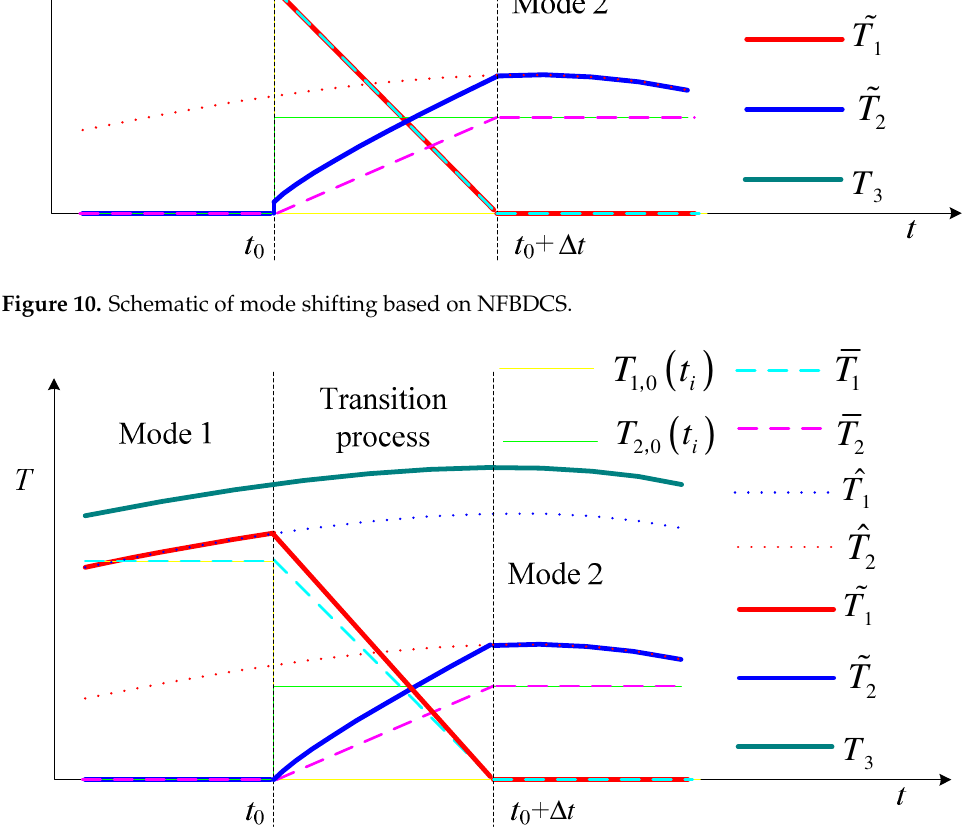
Figure 11. Schematic of mode shifting of NFBDCS by adding the transition